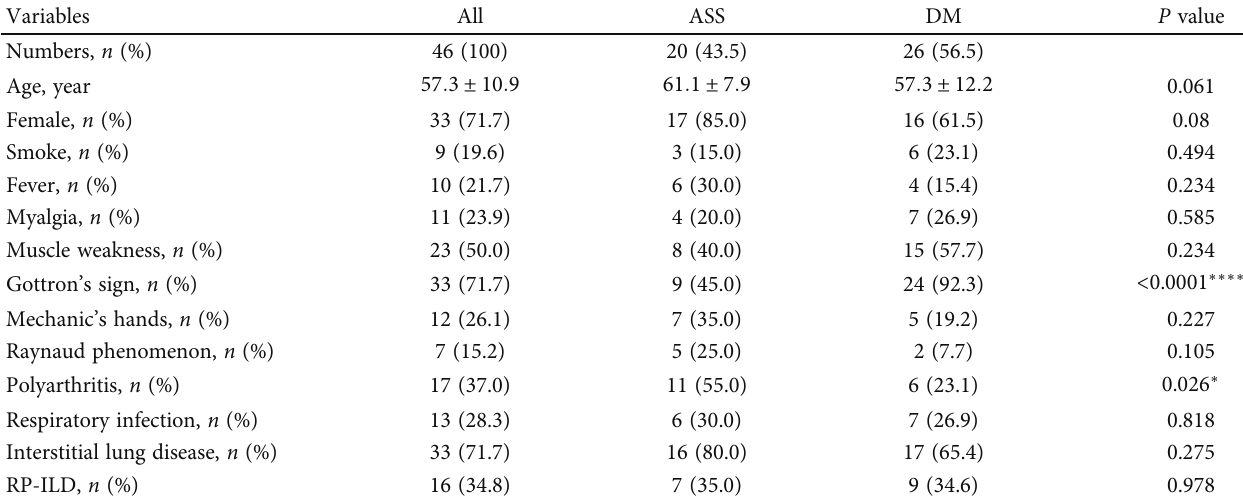
Table 1: Demographic and clinical characteristics of the ASS and DM